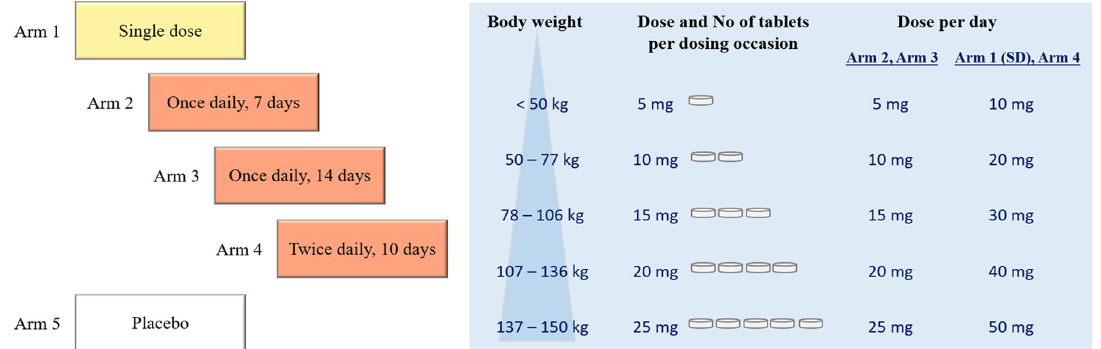
Fig 4. Overview of study arms planned for a phase II clinical trial. Proposed body-weight based dosing regimens for administration of amorphous solid dispersion (ASD) tablet formulation B.